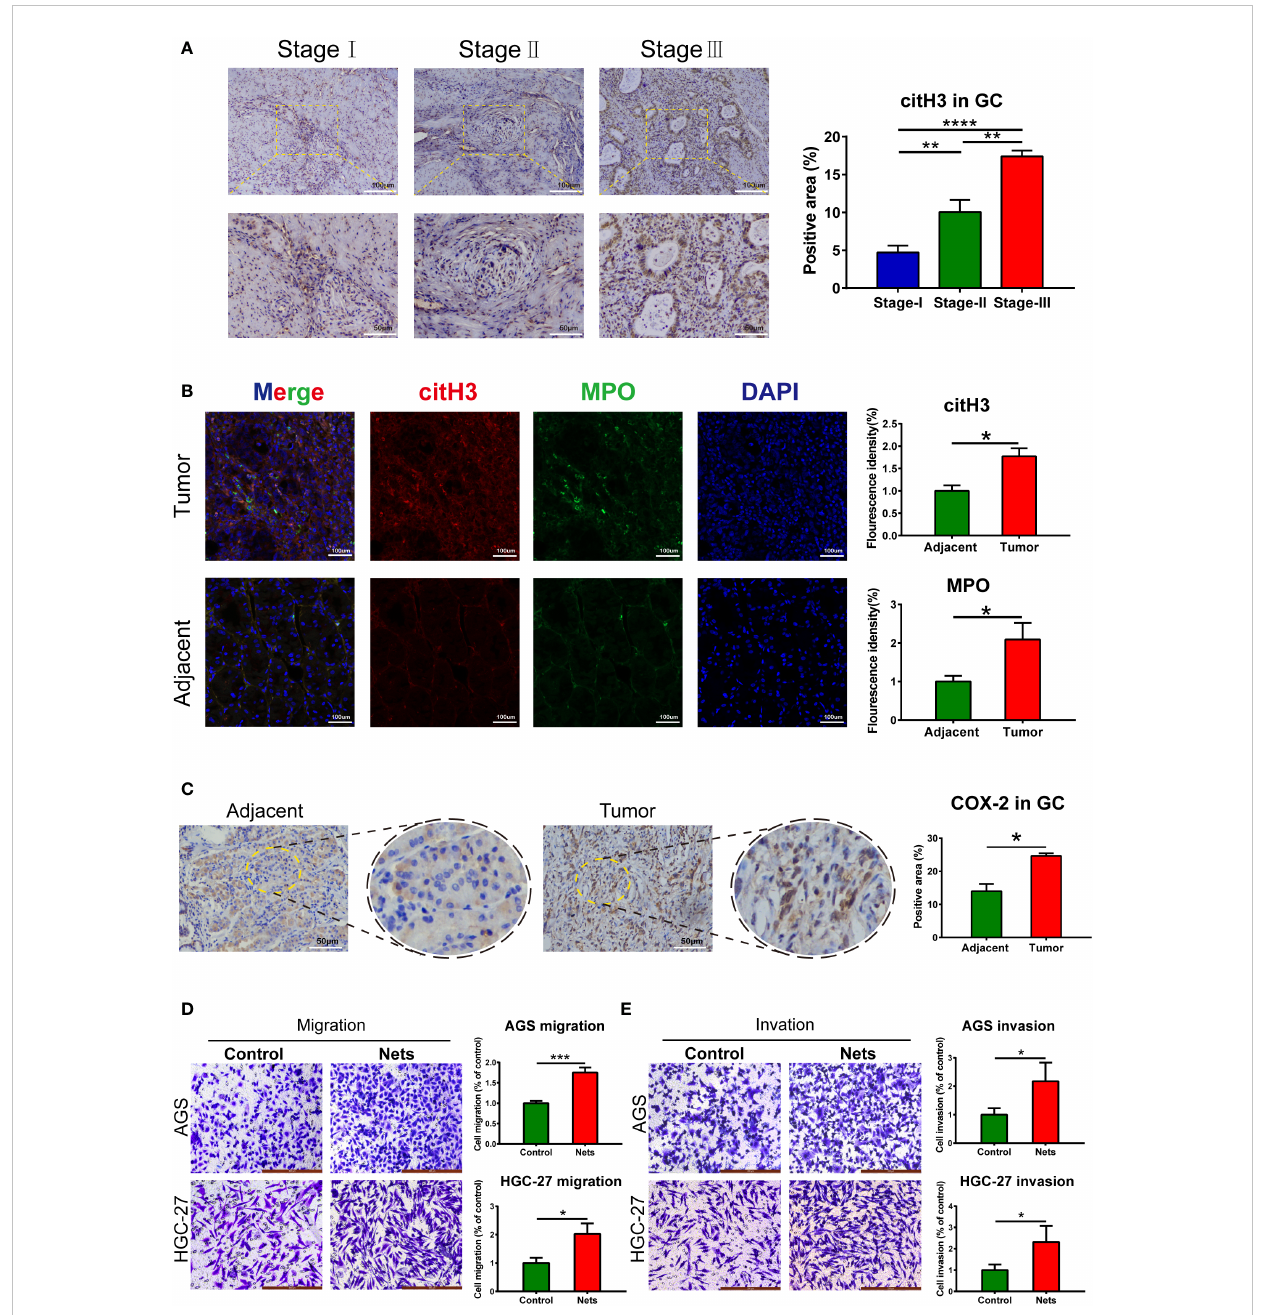
FIGURE 1 NETs and COX-2 in gastric tumor tissues. (A) Expression of cit-H3 in gastric cancer tissues of different stages. (**p<0.01; ****p<0.0001; n=3) (B) Expressions of cit-H3 and MPO separately in gastric cancer and adjacent tissues. The expression of both was assessed by fl uorescence intensity. (*p<0.05 vs. Adjacent; n=3) (C) Representative images of COX-2 expression in gastric cancer and adjacent tissues. The expression of COX-2 was compared by statistical immunohistochemical positive rate. (*p<0.05 vs. Adjacent; n=3) (D, E) The cells crossing the polycarbonate membrane in the control and NETs stimulation groups were measured by migration and invasion assays. (*p<0.05 vs. Control; n=3). All results are presented as mean ±